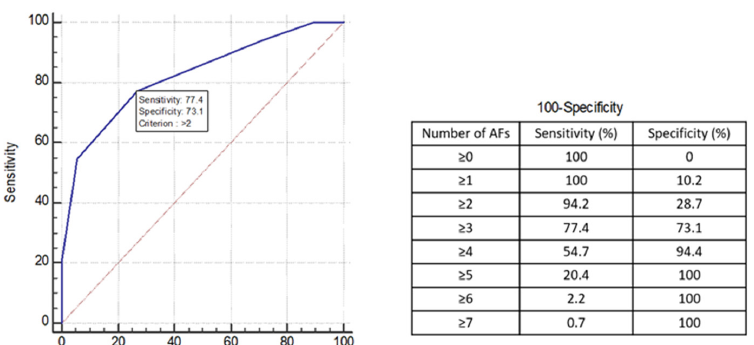
Figure A1. Receiver operating characteristic curve of the number of ancillary features favoring malignancy for the diagnosis of hepatocellular carcinoma and diagnostic performance of each criterion values. Table A3. Diagnostic performance of criteria of applying AFs with various combinations of significant associations.